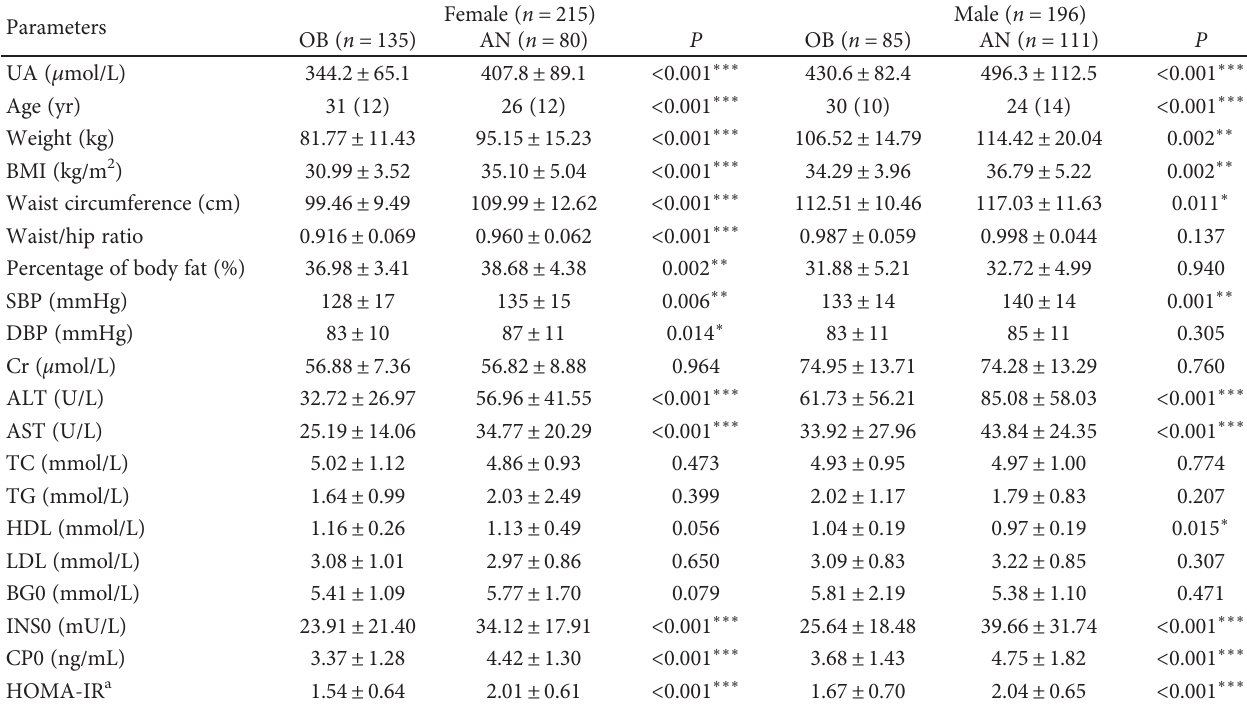
Table 1: General anthropometric and metabolic characteristics of the study cohort divided by females and males.